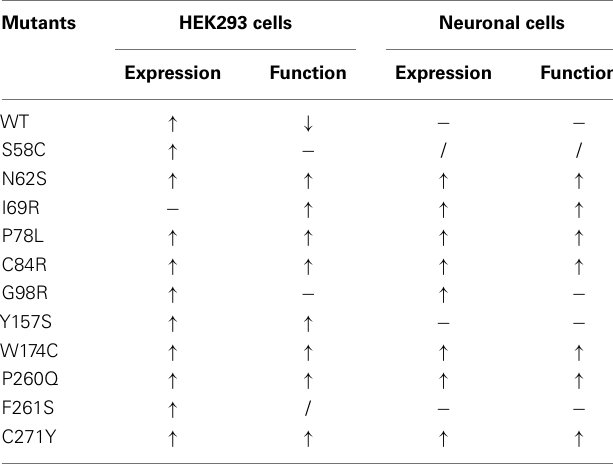
Table 1 | Summary of the effects of Ipsen 5i on the cell surface expression and function ofWT and mutant MC4Rs . Mutants HEK293 cells Neuronal cells Expression